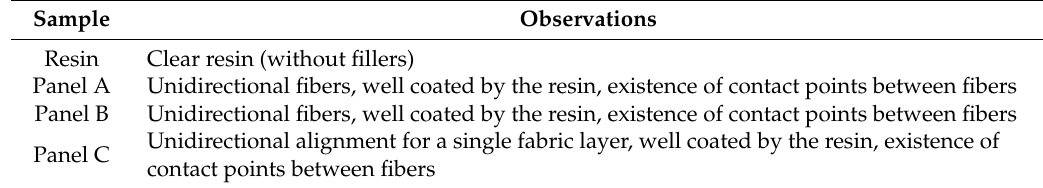
Table 16. Summary of structure observation of CFRP technological